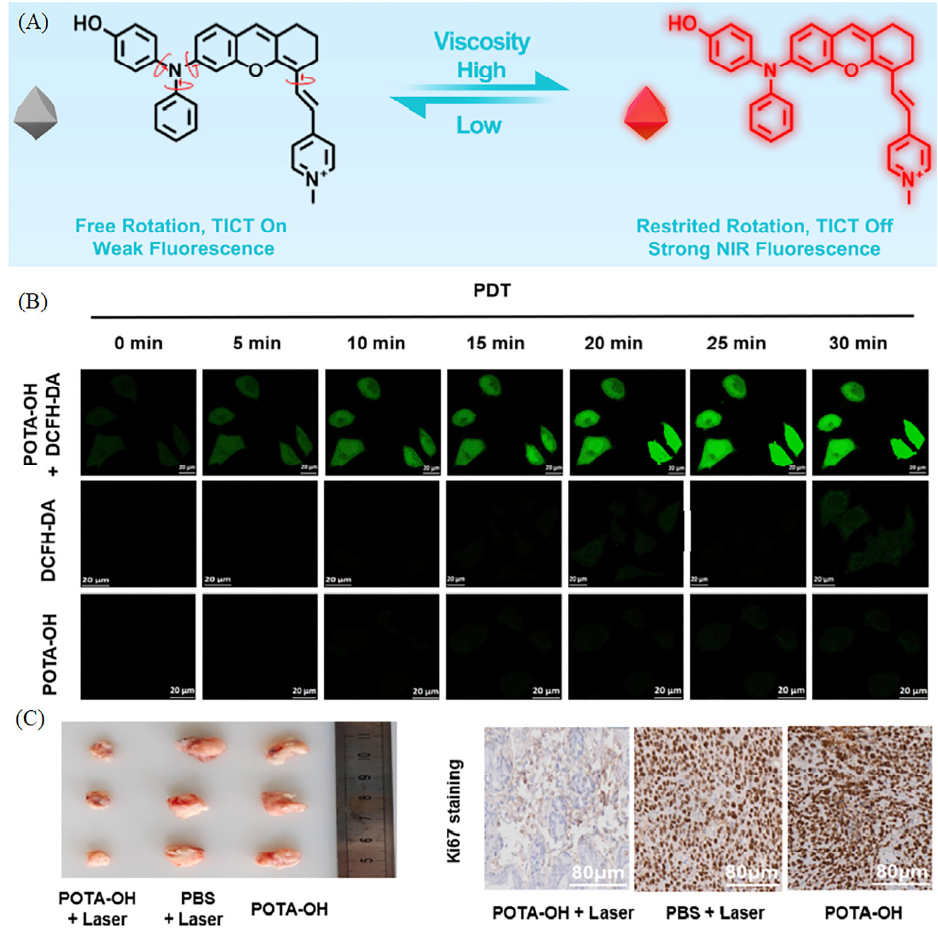
Figure 7. ( A ) The proposed mechanism of POTA-OH in response to viscosity. PDT experiment of probes in living cells ( B ) and tumor tissues ( C ). Reproduced from Ref. [48] with permission of the Elsevier, copyright 2022.